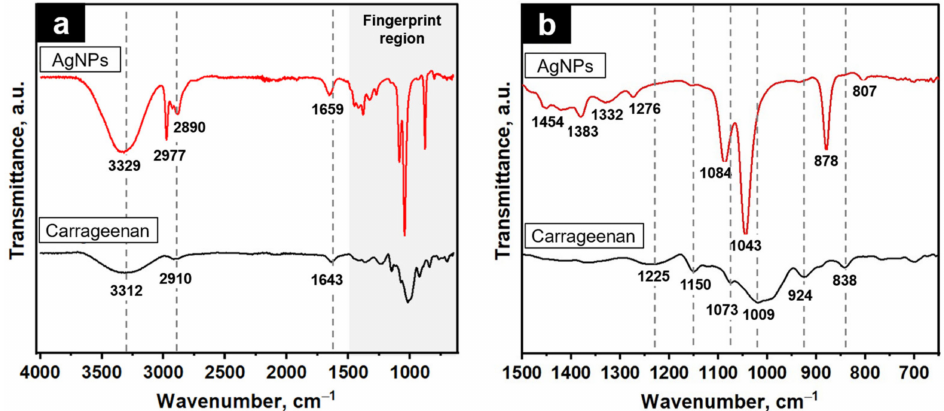
Figure 2. ( a ) FTIR spectra of carrageenan and c-AgNPs; ( b ) corresponding fingerprint